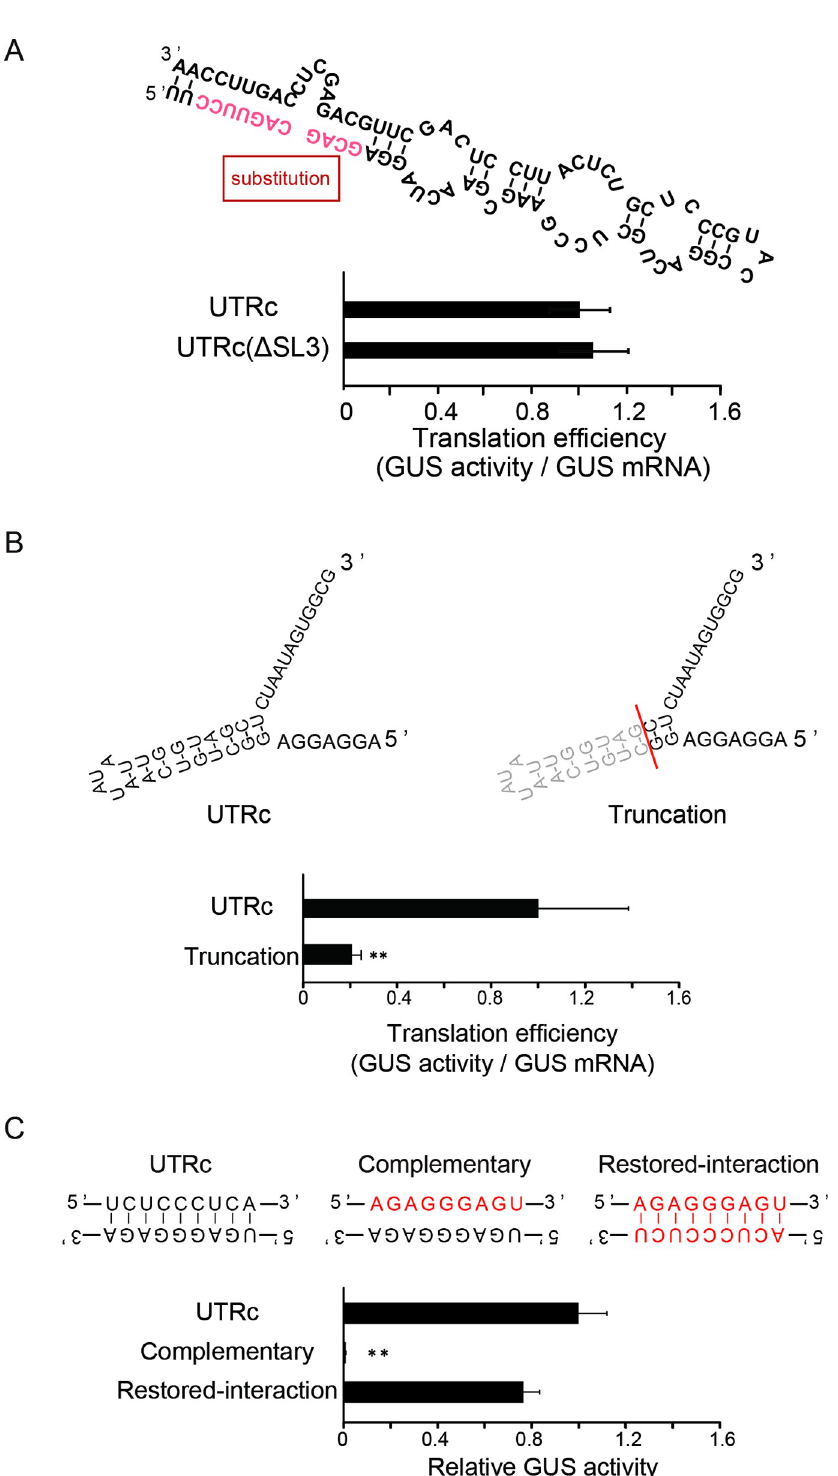
Fig 6. Dependence of the OsMac1 mRNA translation efficiency on secondary and tertiary UTRc structures. (A) Disruption of SL3 stem section 1 is dispensable for UTRc function. Schematic representation of stem section 1 of SL3 (upper panel). Complementary mutations in the 5’ arm of stem section 1 are shown by red letters, UTRc ( Δ SL3). (B) Translational efficiency of SL4 mutants. Schematic representation of entire mutated and truncated SL4 (upper panels). "Truncation" indicates a deletion mutant lacking the stem-loop as indicated. (C) Schematic representation of a base-